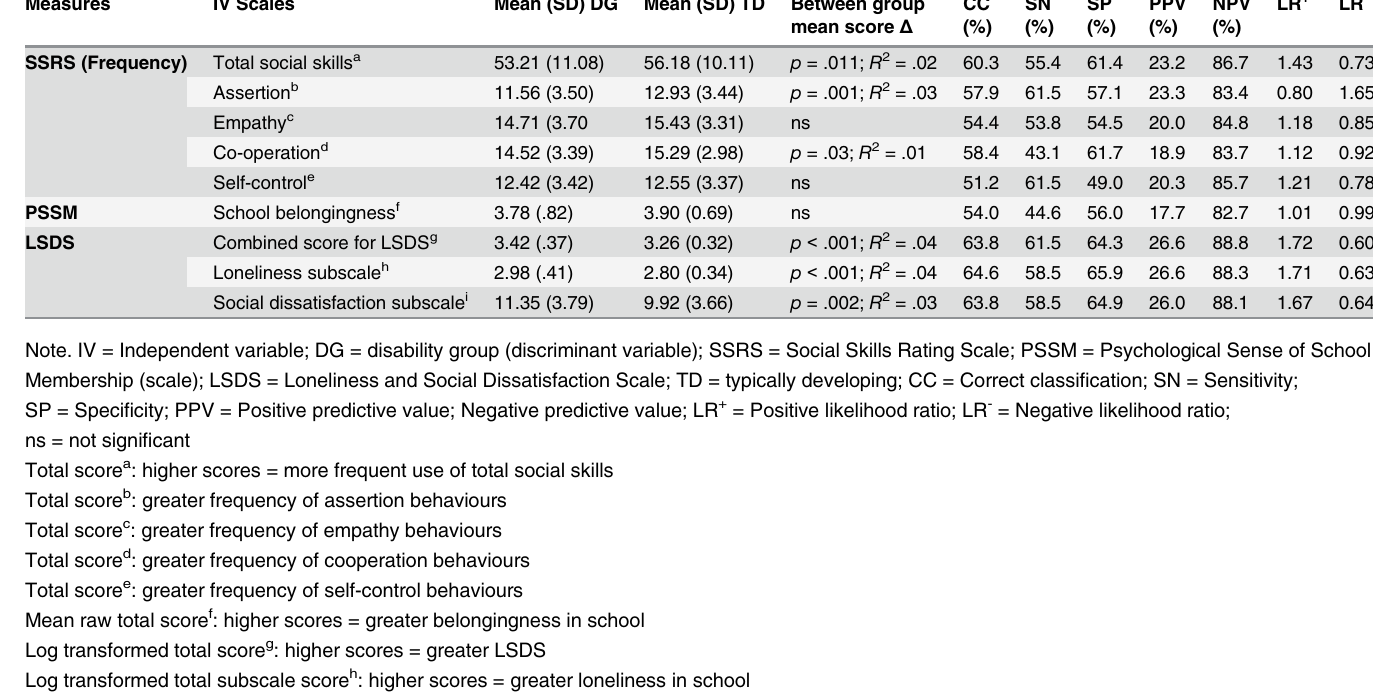
Table 2. Ability of social adaptation factors in differentiating disability in a community mainstream school sample.